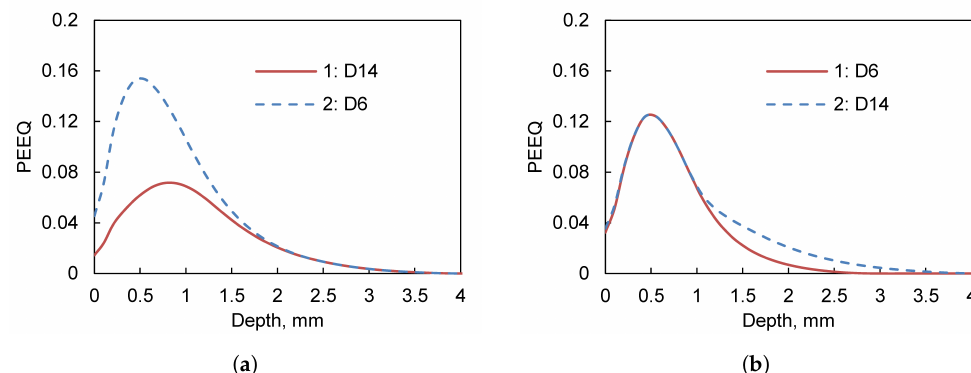
Figure 9. Equivalent plastic strain (PEEQ) combined hammering.